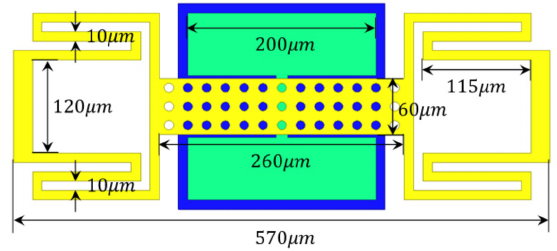
Figure 2. The geometry configuration of the proposed RF MEMS switch.